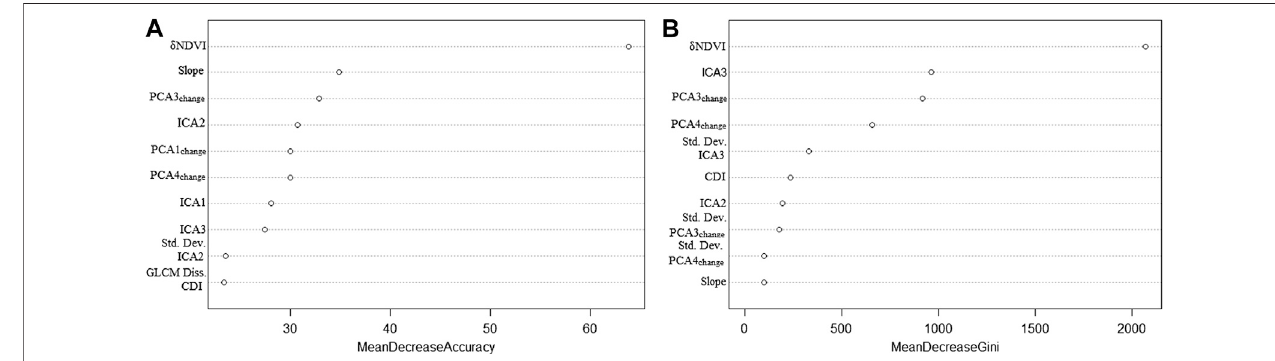
FIGURE3| Thetenmostimportantfeaturesfortheclassi fi erdevelopedwithchange-baseddatasetinmodelarea5: (A) showshowselectedfeaturesaffectmodel accuracy when removed from the dataset, (B) indicates how selected features affect model purity when removed from the dataset.